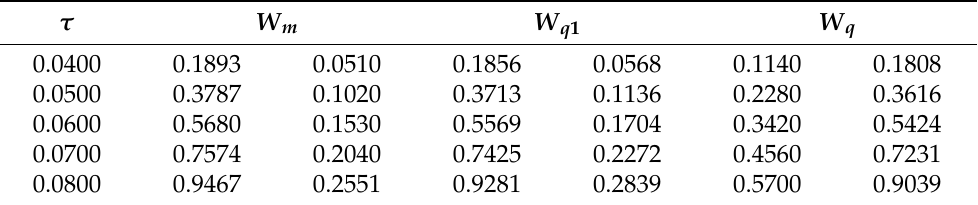
Table 1. Optimal portfolio weights in the risky